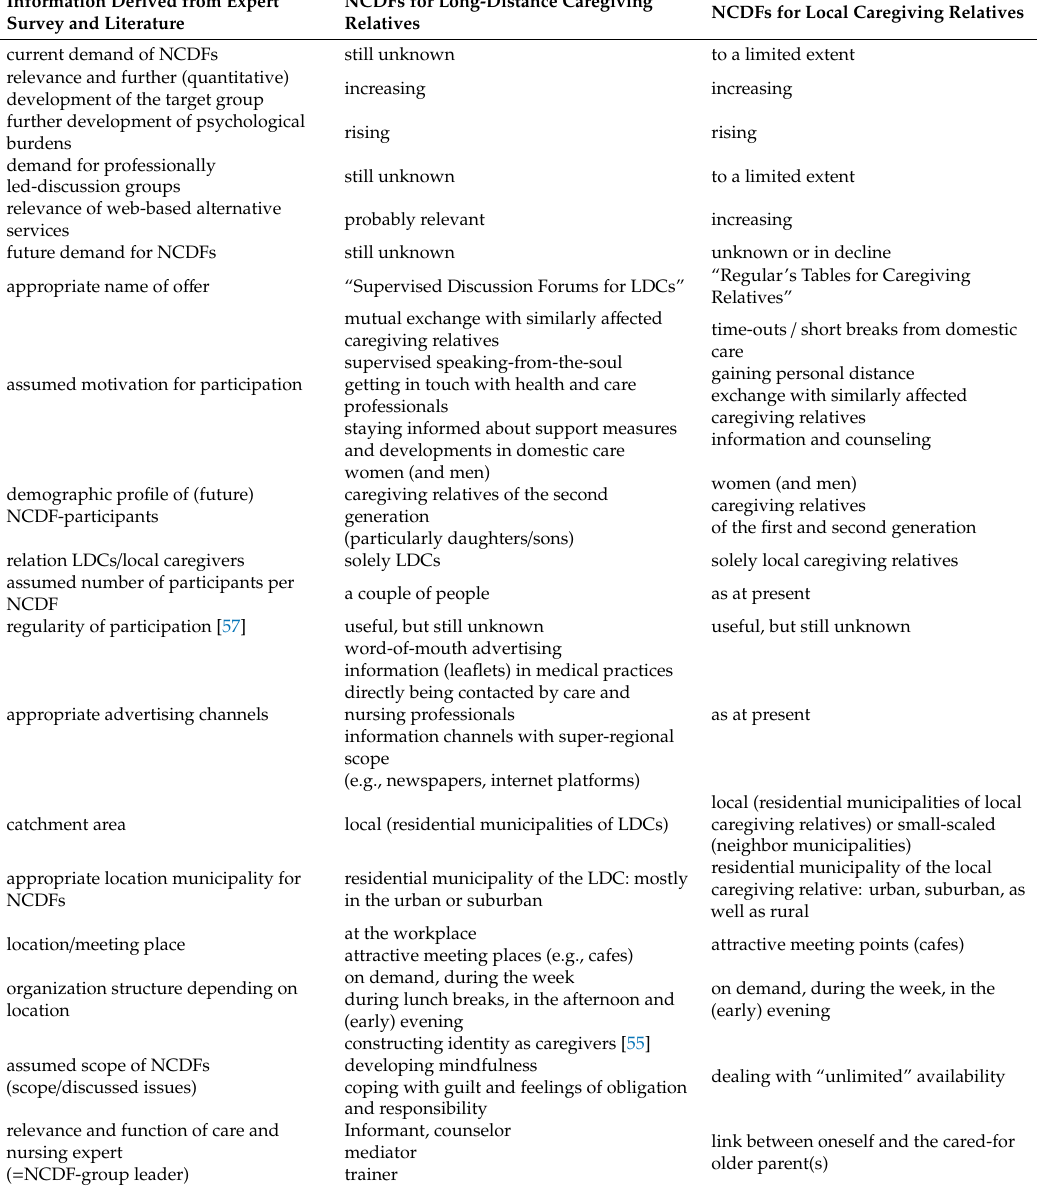
Table 7. Considerations on the requirements for LDCs’ and local caregiving relatives’ suitable